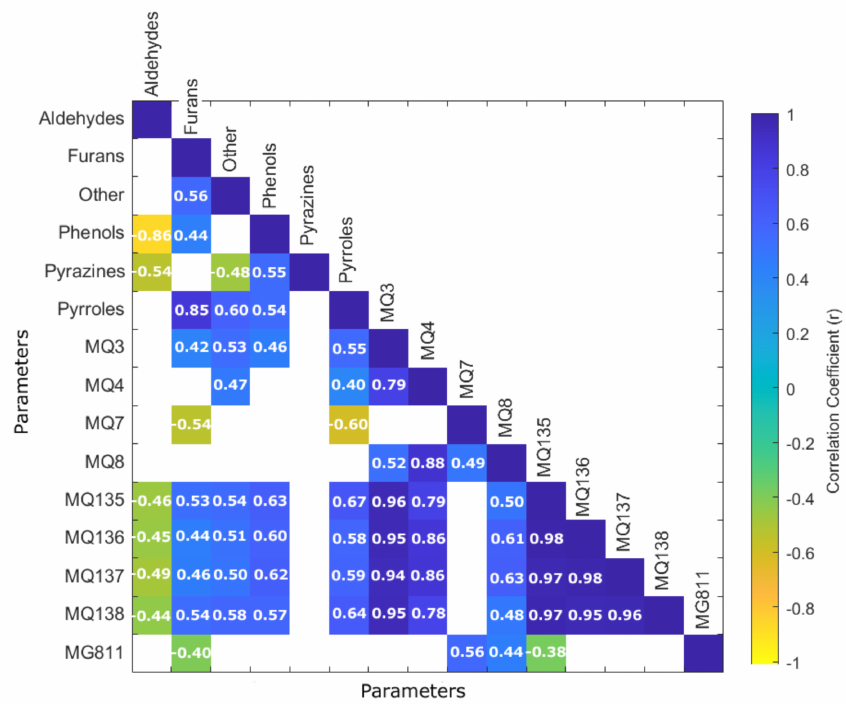
Figure 5. Matrix showing the significant correlations ( p < 0.05) between the volatile aromatic com- pounds functional groups and the sensors integrated into the electronic nose. Correlation coefficients are depicted with different colors according to the color bar in which yellow represents the negative correlations, while blue shows the positive